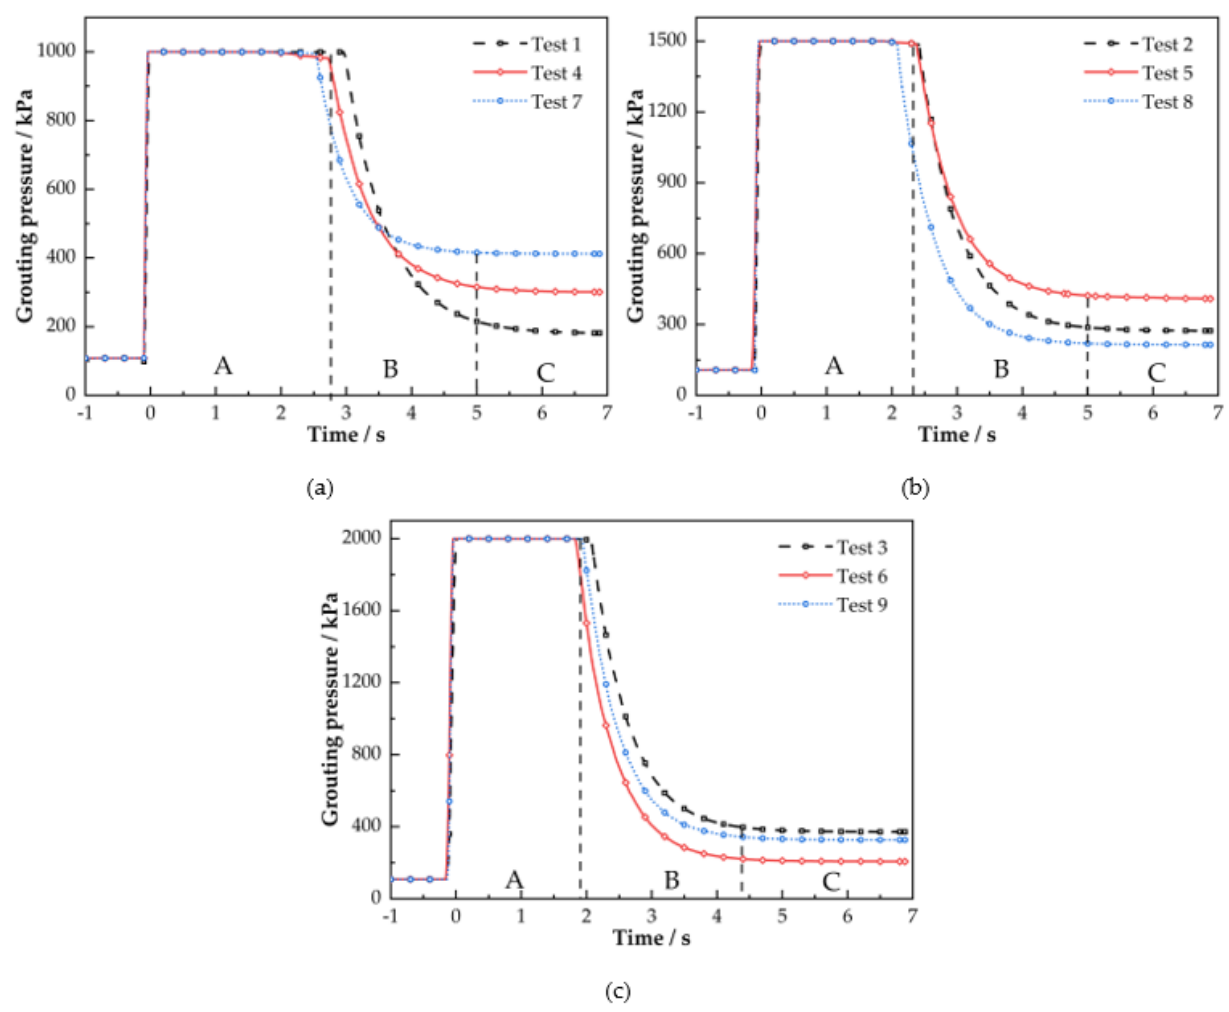
Figure 9. Grouting pressure curve: ( a ) test 1, 4, 7; ( b ) test 2, 5, 8; ( c ) test 3, 6, 9. Table 5. Analysis table for the orthogonal test of final pressure of slurry